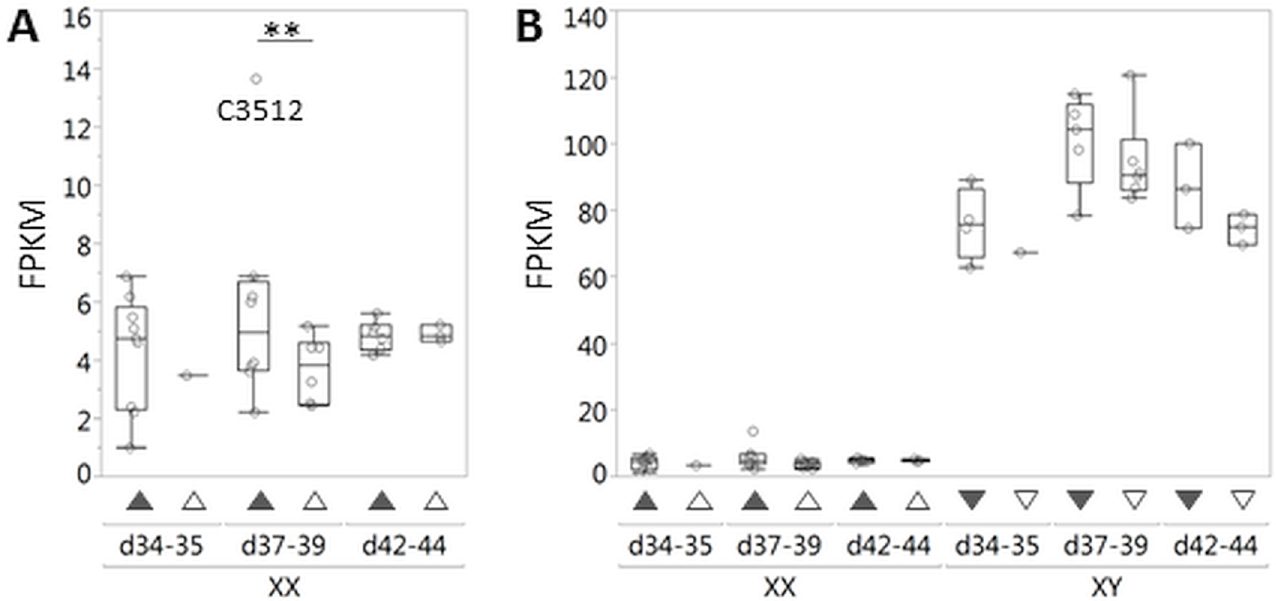
Fig 5. SOX9 expression in canine embryonic gonads was measuredby RNA-seq. (A) At d37-39, SOX9 expressionwas significantly greater in XX DSD gonads at risk (filled triangles)comparedto XX age-matched control gonads(open triangles), but < 2 fold and primarilydue to one sample (C3512).Each open circle represents RNA from one embryonic gonad pair, except for d34, which represents RNA from a gonadpool. Differential expressionwas statistically tested for XX DSD gonadscomparedto XX age-matched controls at d37-39and d42-44( ** p-value (cid:20) 0.00005). (B) At all ages tested, SOX9 expressionin XY littermate (filled invertedtriangles)and XY age-matched control gonads(open inverted triangles) was much greater than in XX DSD gonadsat risk (filled triangles)and XX age-matched controls (open triangles). Each opencircle representsRNA from one embryonic gonad pair, except for d34, which represents RNA from a gonad pool. FPKM is Fragments Per Kilobaseof transcript per Million mapped reads.